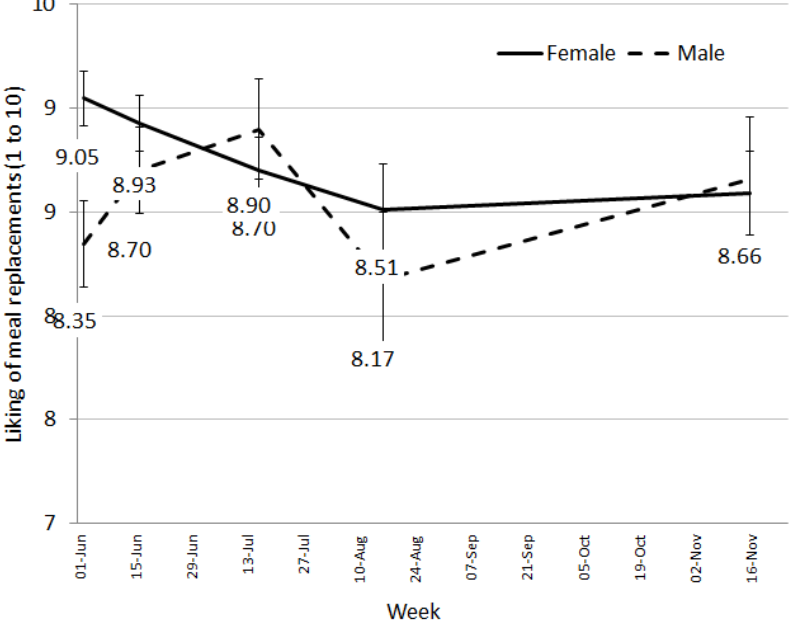
Figure 4. Adjusted means for liking presented by sex and week.